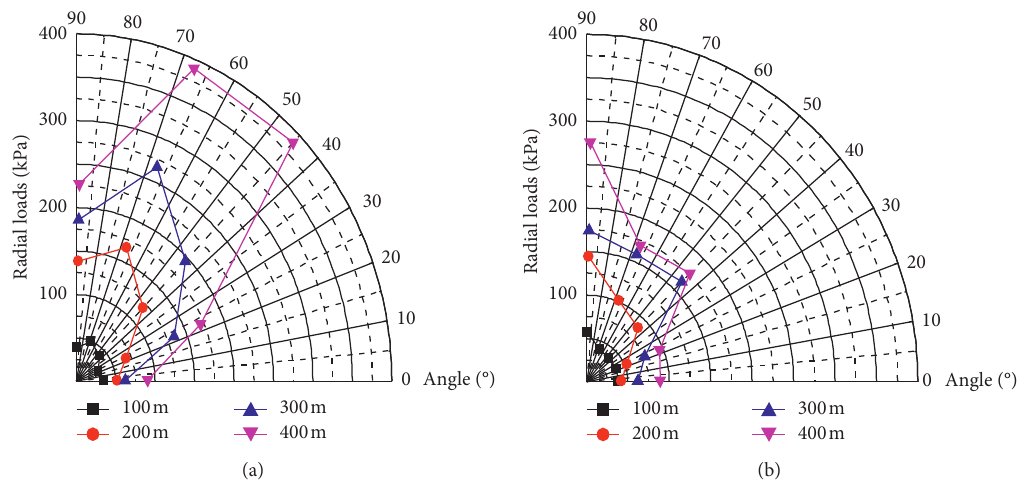
Figure 14: The radial loads calculated estimated using the CCCs: (a) No BDZ; (b)